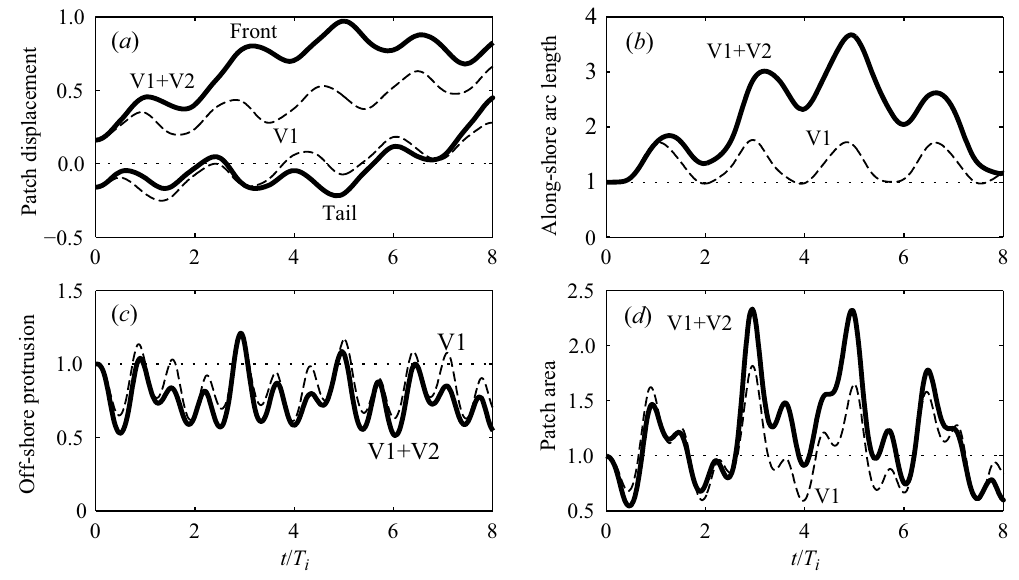
Fig. 6. Time series of (a) along-shore displacement of cloud front and tail vertices, (b) along-shore arch length of the cloud on the basin perimeter side, (c) off-shore protrusion of the cloud, and (d) cloud patch area, obtained in V1-only field and V1 + V2 field. A cloud patch of radius r 0 / 2 is initially placed at the right end of the basin relative to the positive wind vector. The along-shore displacement (a) is normalized by πr 0 , the along-shore length (b) and the patch area (c) are normalized by their respective initial values, and the off-shore protrusion (d) is normalized by their initial radius of the cloud patch. ( B = 2, h 2 = 1, h 3 = 2, W =